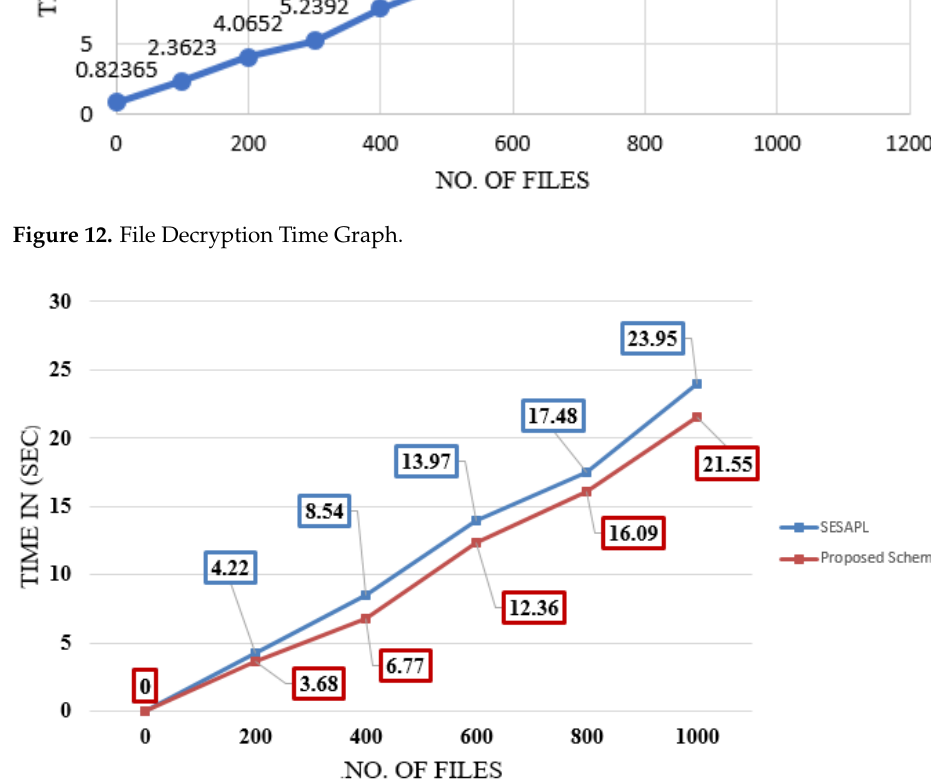
Figure 13. Comparative Computational